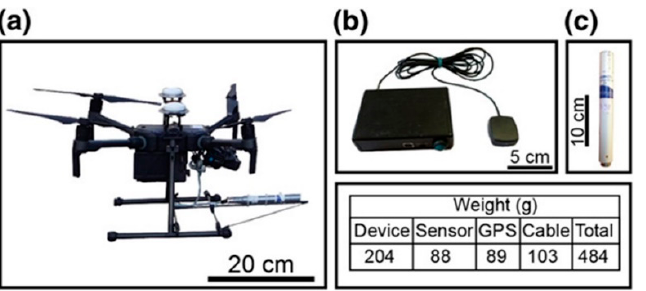
Figure 14. ( a ) The Matrice 210 RTK quadcopter designed by Da Jiang Innovation ( b ) and the Bartington MAG03-MC fluxgate magnetometer ( c ). The overall weight of the magnetic equipment is 484 g.